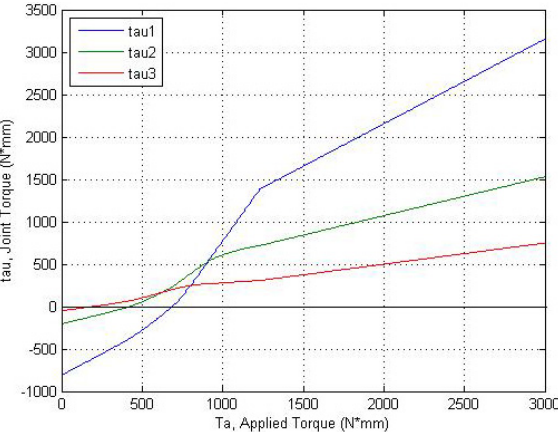
Figure 7. Closing sequence with no